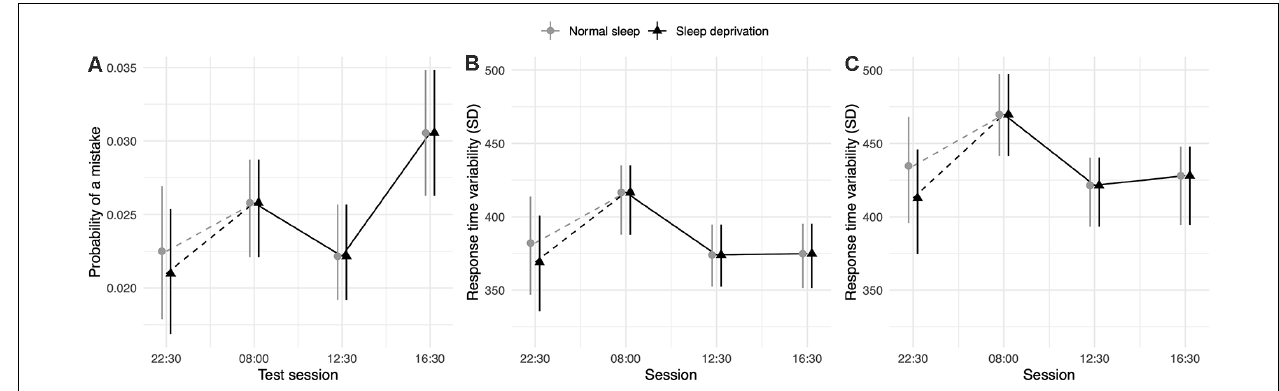
FIGURE 5 | Strooptest performance depending on time-of-day. (A) Represents performance measured by the probability of making a mistake on the test. (B) Represents performance measured by the standard deviation of the difference in RT (in ms) between a cI and a preceding cC trial (cognitive conflict). (C) Represents performance measured by the standard deviation of the difference in RT (in ms) between aiI and a preceding cI trial (behavioural adjustment). Dots represent fixed-effect estimates and error bars represent bootstrapped confidence intervals with 100 iterations. The dotted line between 22:30 h and 08:00 h represents the night of total sleep deprivation for the sleep-deprivation group. Note that normal sleep and sleep deprivation conditions show identical estimates since the effect of sleep deprivation was not included in the model.